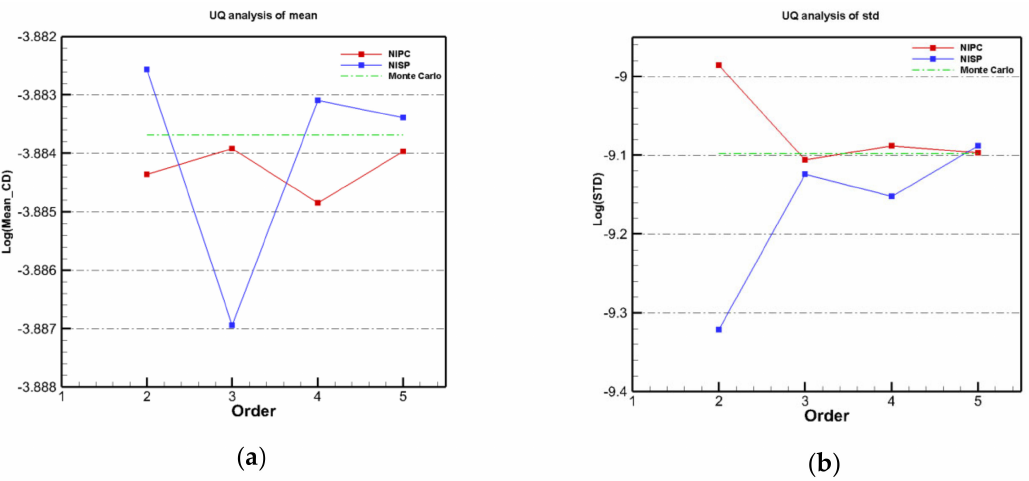
Figure 7. The mean and standard deviations of the drag coefficient of the three methods for Orders 2–5: ( a ) mean value; and ( b ) standard